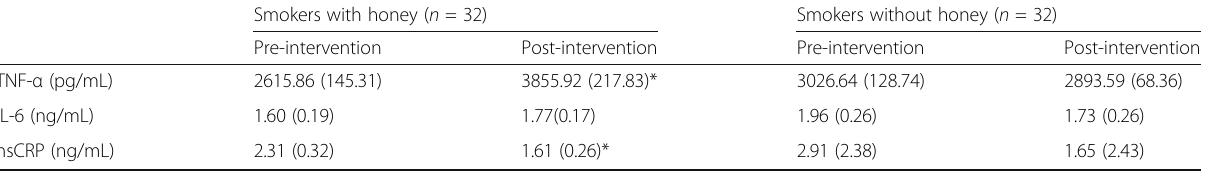
Table 3 Pre-intervention and post-intervention inflammatory markers in smokers Smokers with honey ( n = 32) Smokers without honey ( n = 32) Pre-intervention Post-intervention Pre-intervention